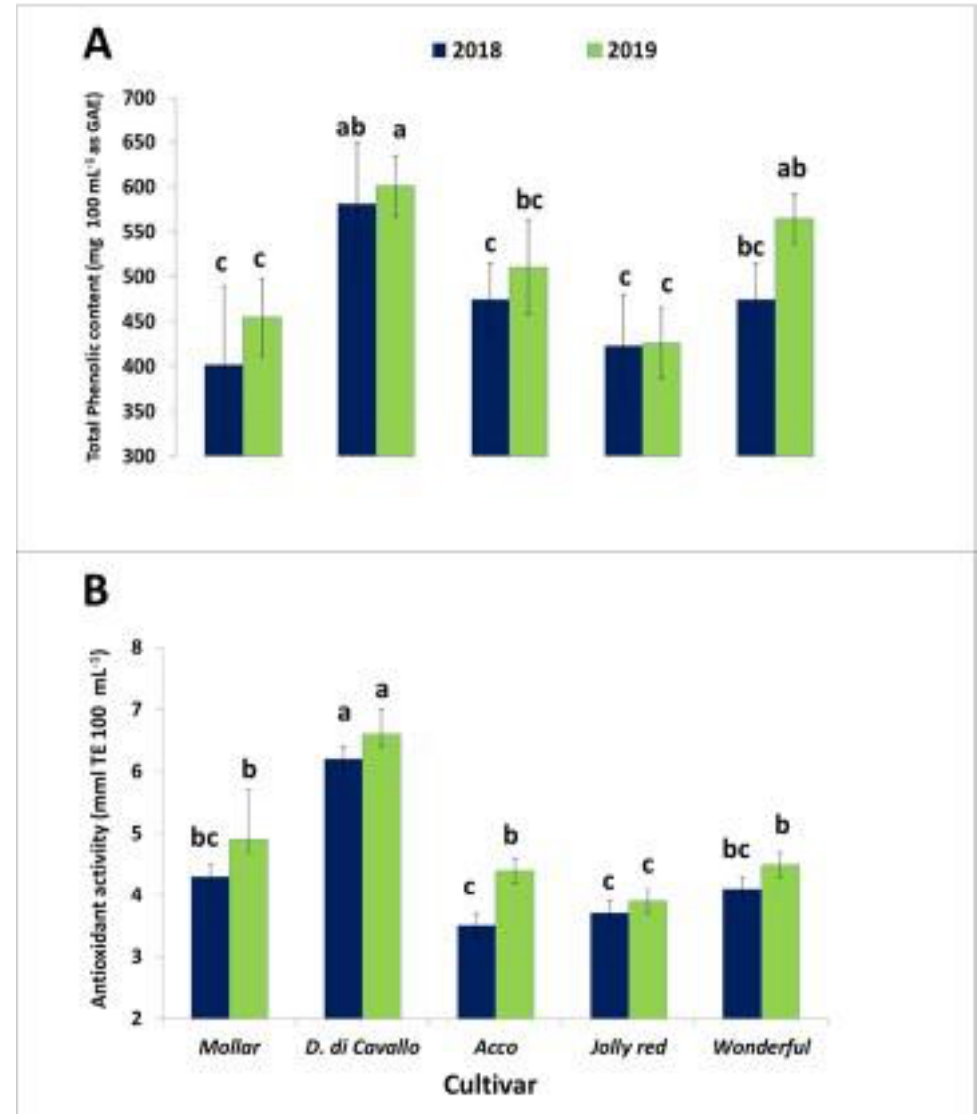
Figure 2. Total phenolic content ( A ) and antioxidant activity ( B ) in different pomegranate cultivars. Average values ± std. dev. in 2018 and 2019 are shown. Different letters per year indicate significant differences at p <